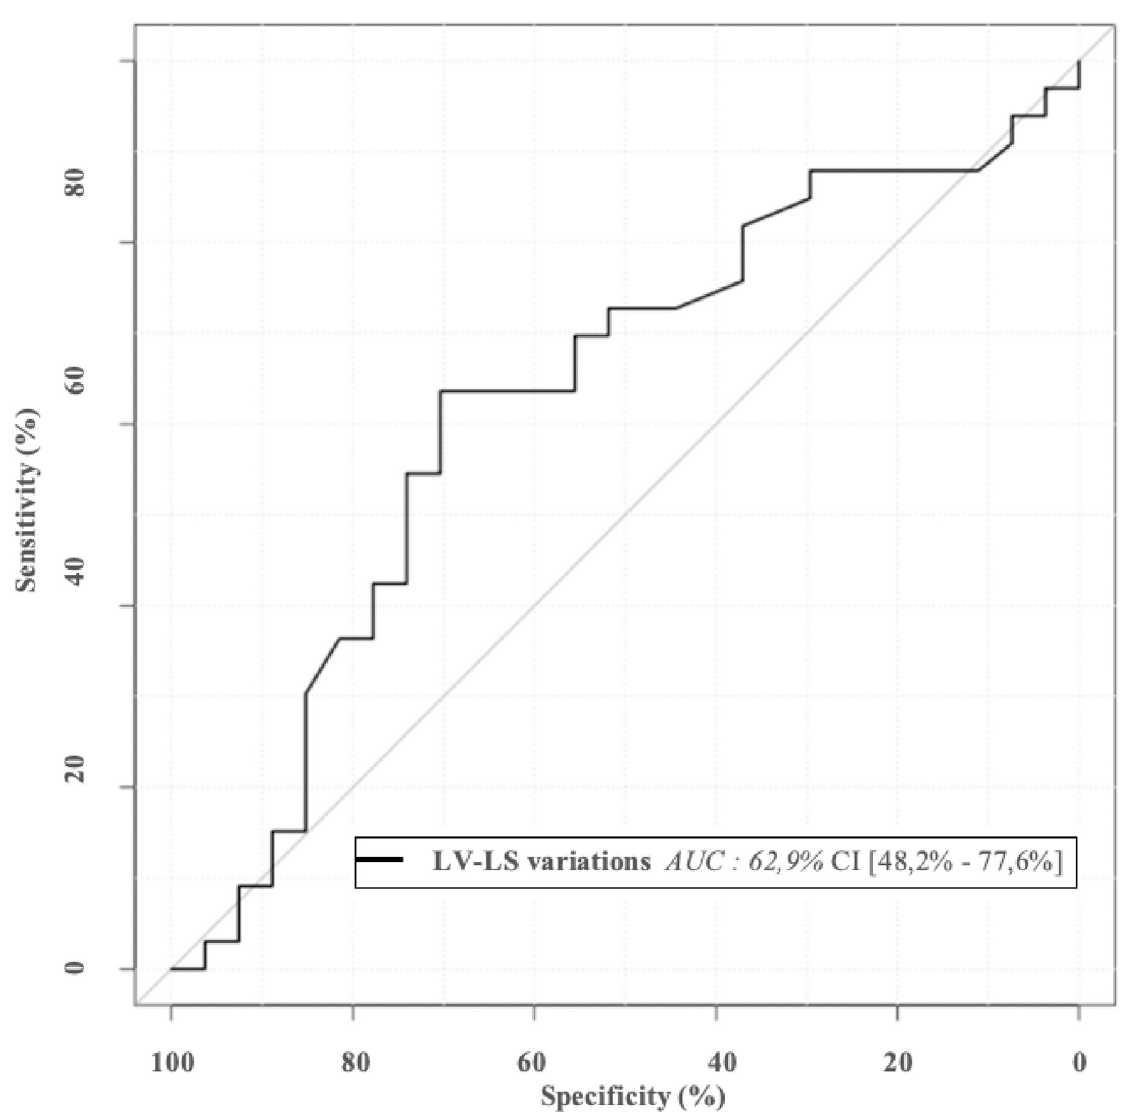
Fig 5. Receiver operating curve for evaluation of LV-LS variations during PLR to predict fluid responsiveness. AUC: area under curve.